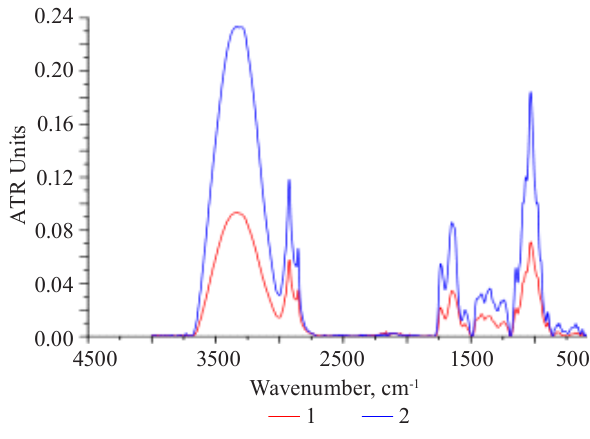
Figure 7 IR-spectra of PS-complexes of industrial flax seeds in an acidic medium: (1) fibrous, (2) amorphous